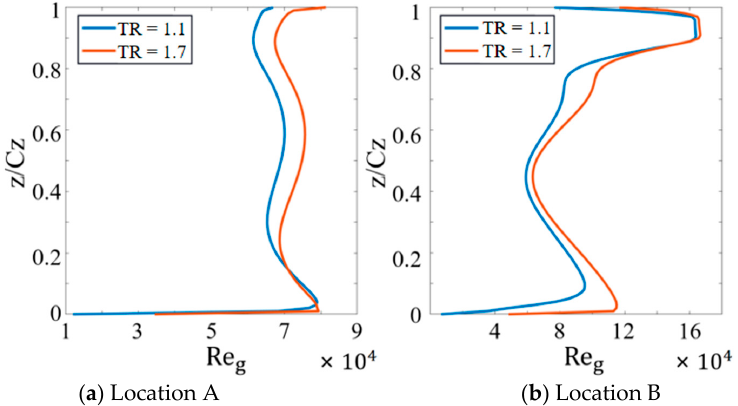
Figure 7. Local Reynolds number Re g distribution along the gap height at two typical locations.